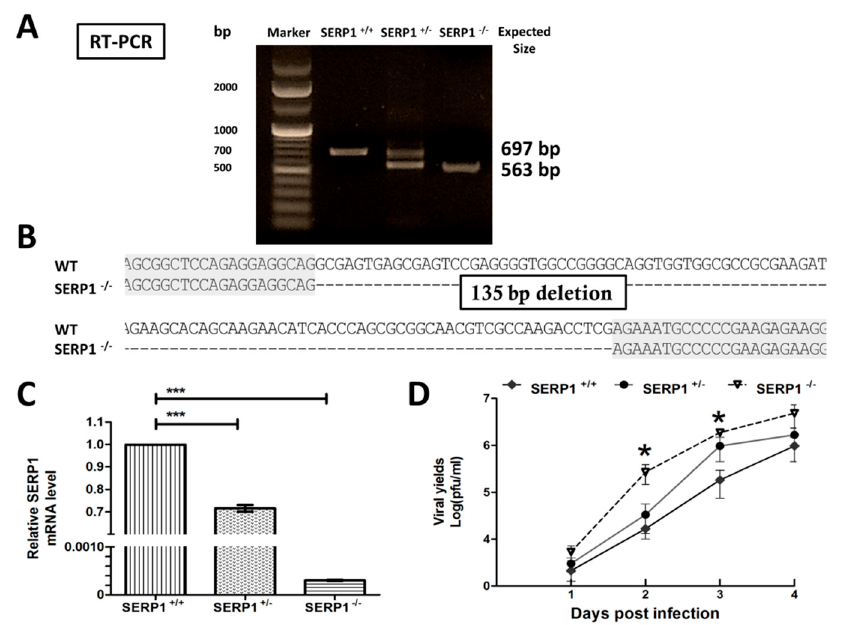
Figure 4. Knockout of SERP1 by the II clustered regularly interspaced short palindromic repeats (CRISPR) / Cas9 system in Huh7.5 cells decreased SERP1 mRNA levels, and viral yields were significantly enhanced in the SERP1 knockout cells. ( A ) SERP1 RNA expression patterns in the SERP1 knockout sublines. The products of RT-PCR performed on RNA isolated from the parental Huh7.5 cells (SERP1 +/+ ) and SERP1 knockout sublines (SERP1 +/ − and SERP1 − / − ) using the primers in SERP1 exon 1 and exon 3, which generate a 697 bp product. The SERP1 mutant allele was amplified as a 563 bp product, where the SERP1 exon 1 region was deleted. ( B ) Sequencing analysis of the parental Huh7.5 cells and SERP1 knockout cell lines from the RT-PCR product. ( C ) Detection of SERP1 mRNA levels in the parental Huh7.5 cells and SERP1 knockout sublines by qRT-PCR. The expression values are normalized to β -actin expression. ***, p < 0.001 (Student’s t -test). ( D ) Kinetics of DENV-2 replication in the parental cells and SERP1 knockout sublines. The parental Huh7.5 cells and SERP1 knockout sublines were infected with DENV-2 (MOI = 1) at the indicated times. Infectious virus yield in the BHK21 clone 15 cells was quantified by plaque assay. The di ff erences in virus yields between the parental cells (SERP1 +/+ ) and SERP1 knockout cells (SERP1 − / − ) at 2 or 3 d.p.i. were analyzed using Student’s t -test. *, p <